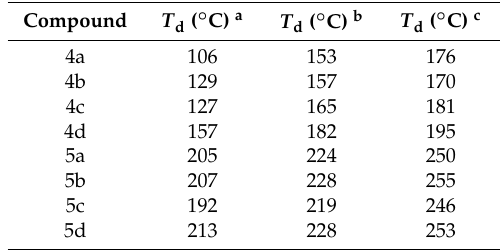
Table 1. Summary of structures and thermal decomposition temperatures of precursors with chloride anion (4a–4d) and B-L MILs (T d : thermal decomposition